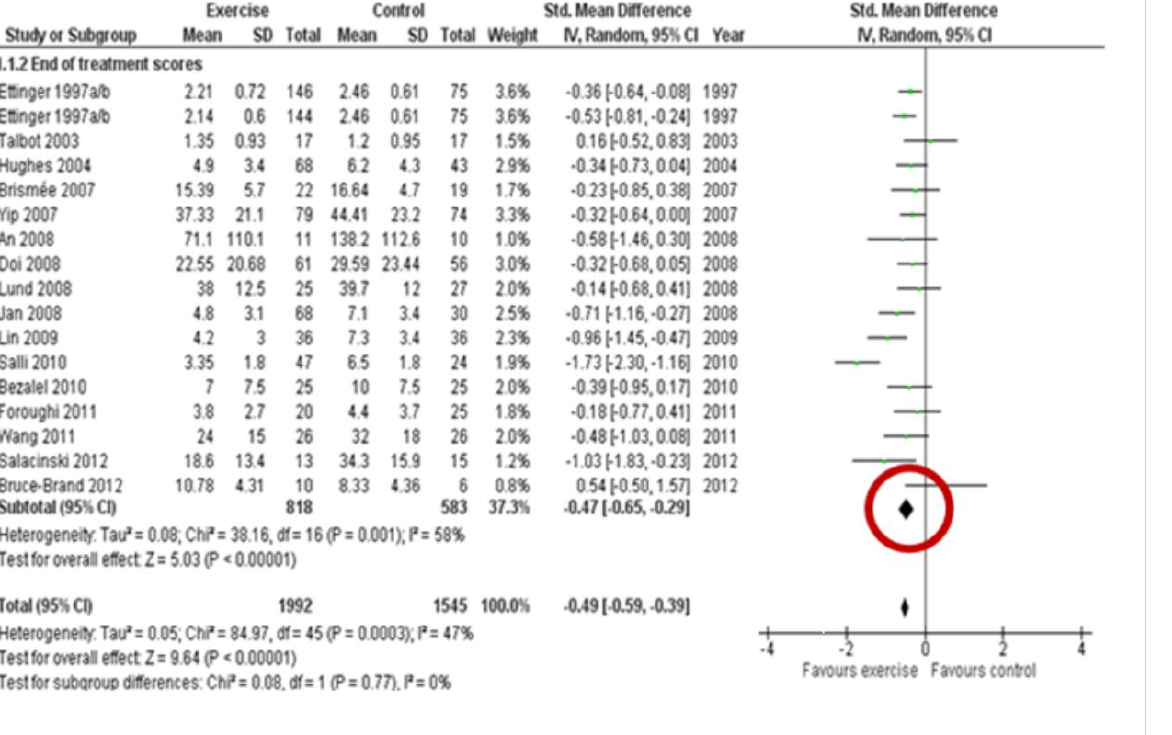
Figure F10-2. Effects of Land-based Exercise on Pain, Physical Function, and Quality of Life in Knee Study or Subgroup IV, Random, 95% CI Year